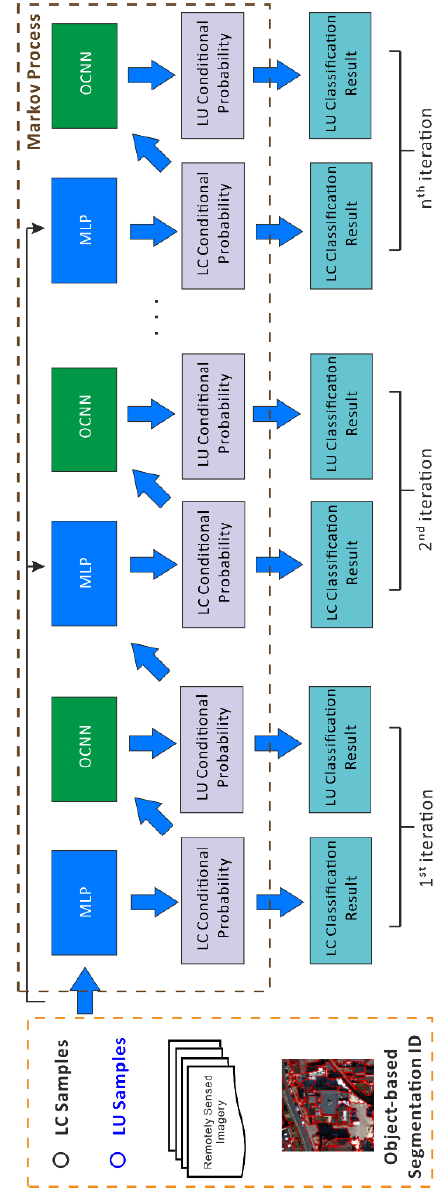
Figure 4. The joint deep learning (JDL) to classify land cover and land use in a single unified